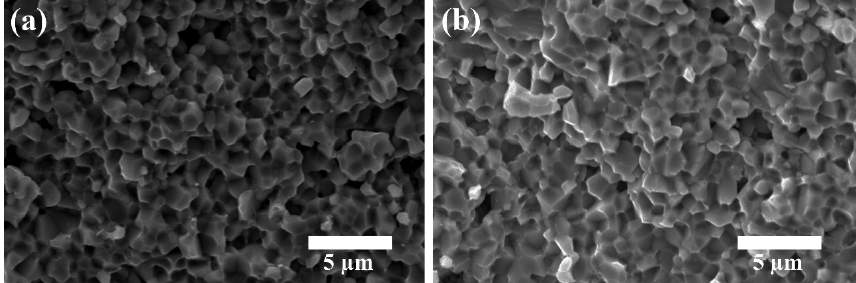
Fig. 5 SEM images of the flash-sintered sample on both sides of the electrode: (a) anode (+), (b) cathode (–) at x = 3